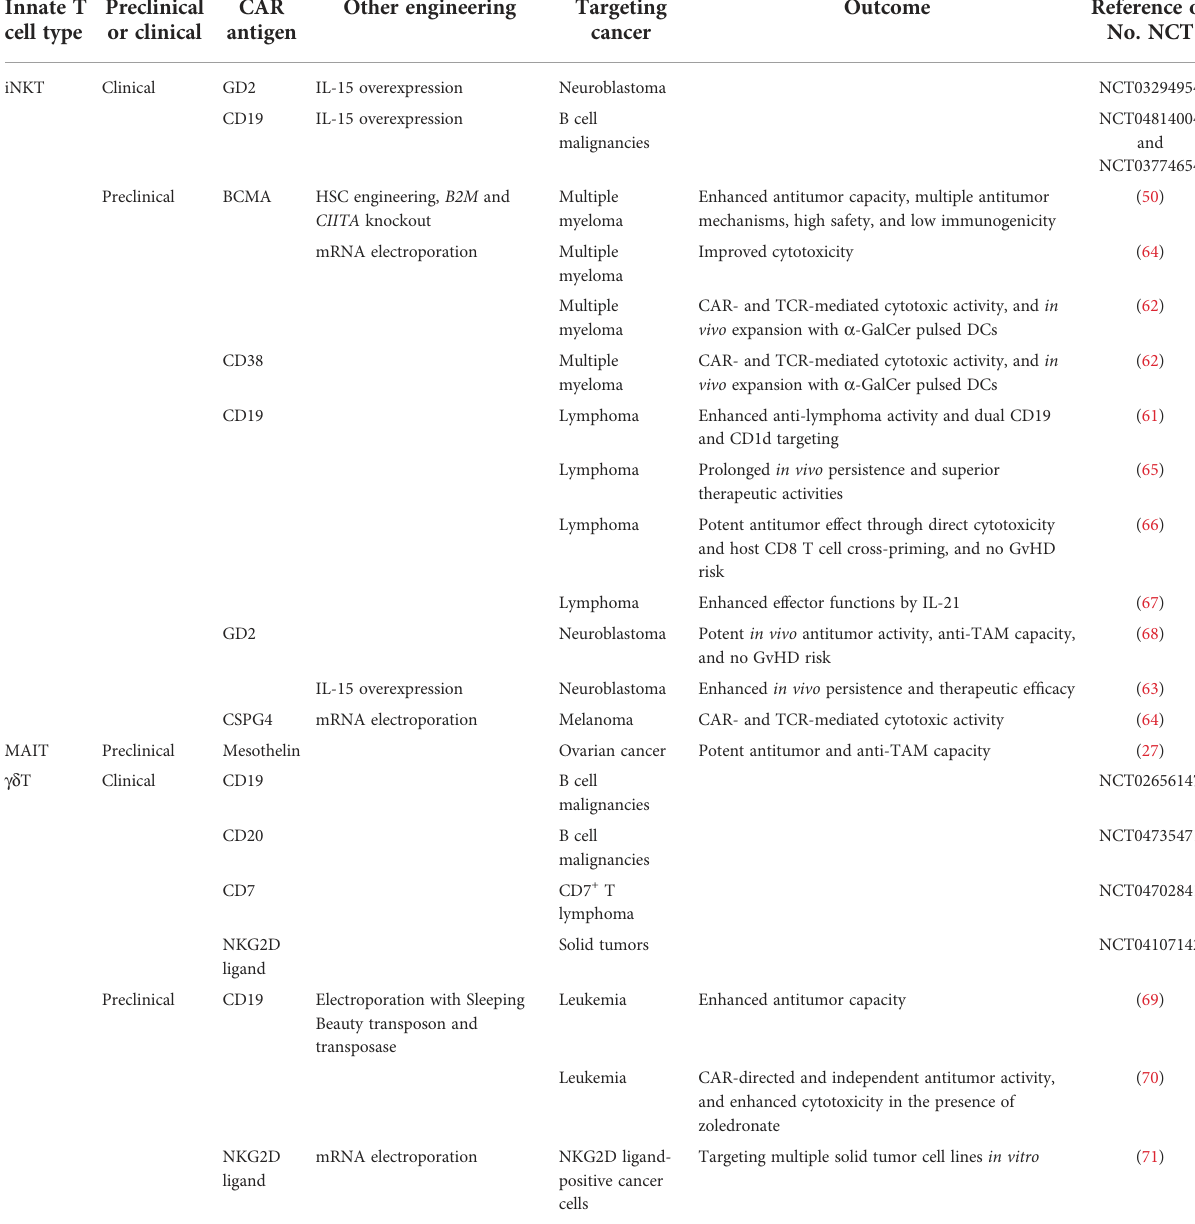
TABLE 2 Preclinical and Clinical Trials of Innate T cell CAR-Based Therapies. Innate T Preclinical cell type or